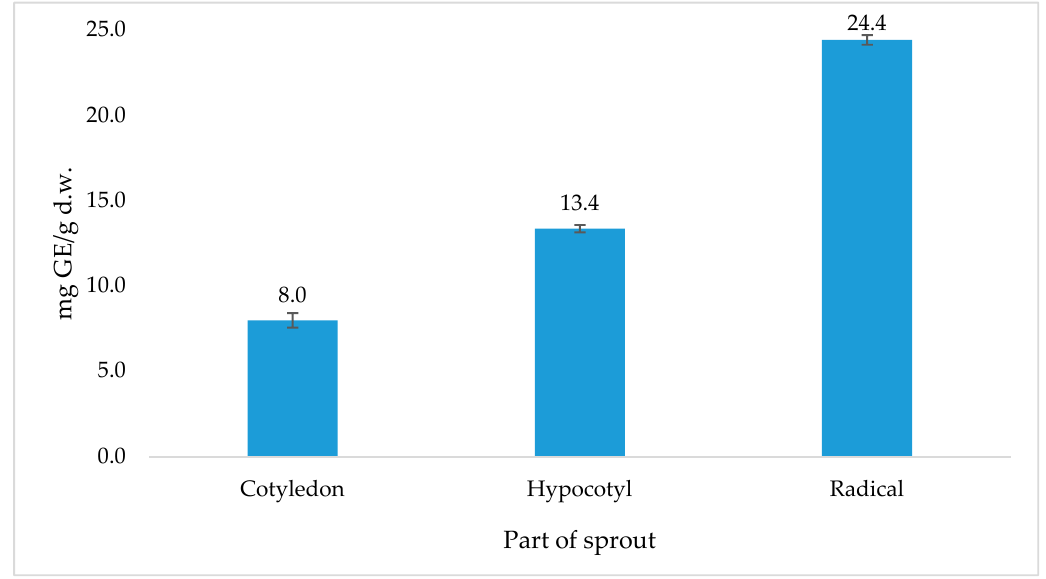
Figure 8. The polyphenol content in different parts of soybean sprouts.